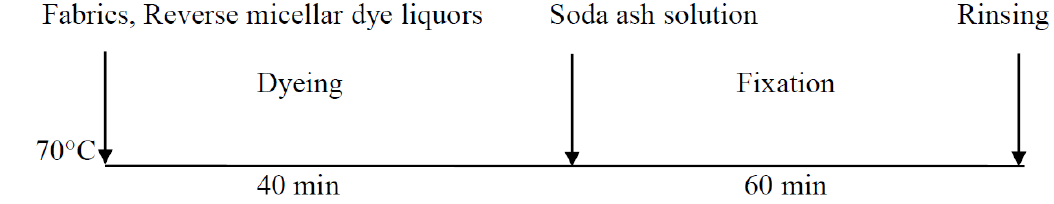
Figure 2. The dyeing profile of the reverse micellar D5 solvent dyeing.